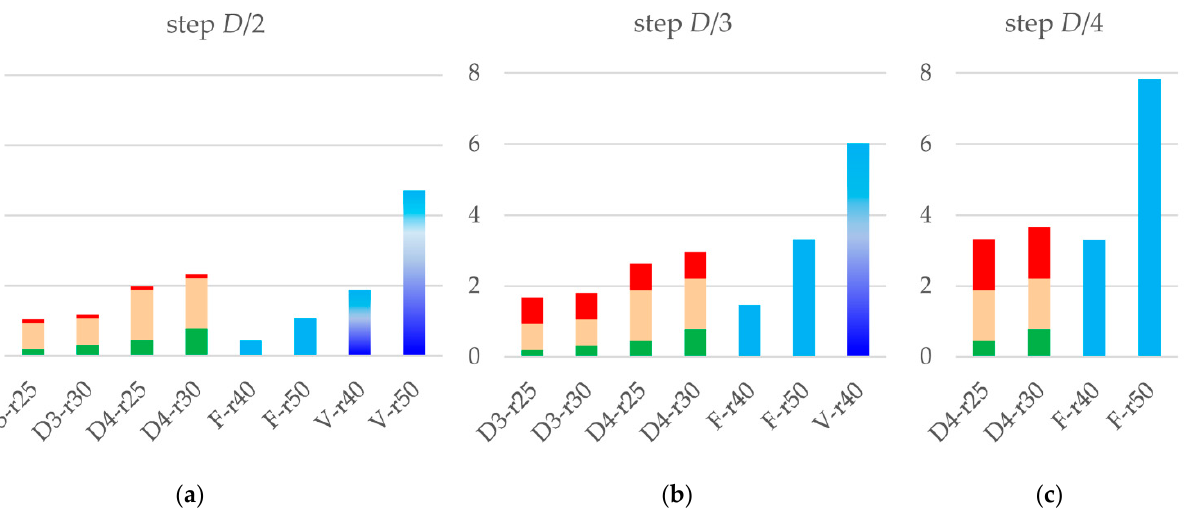
Figure 6. CPU time, in seconds, for different values of parameters used to calculate the model map.